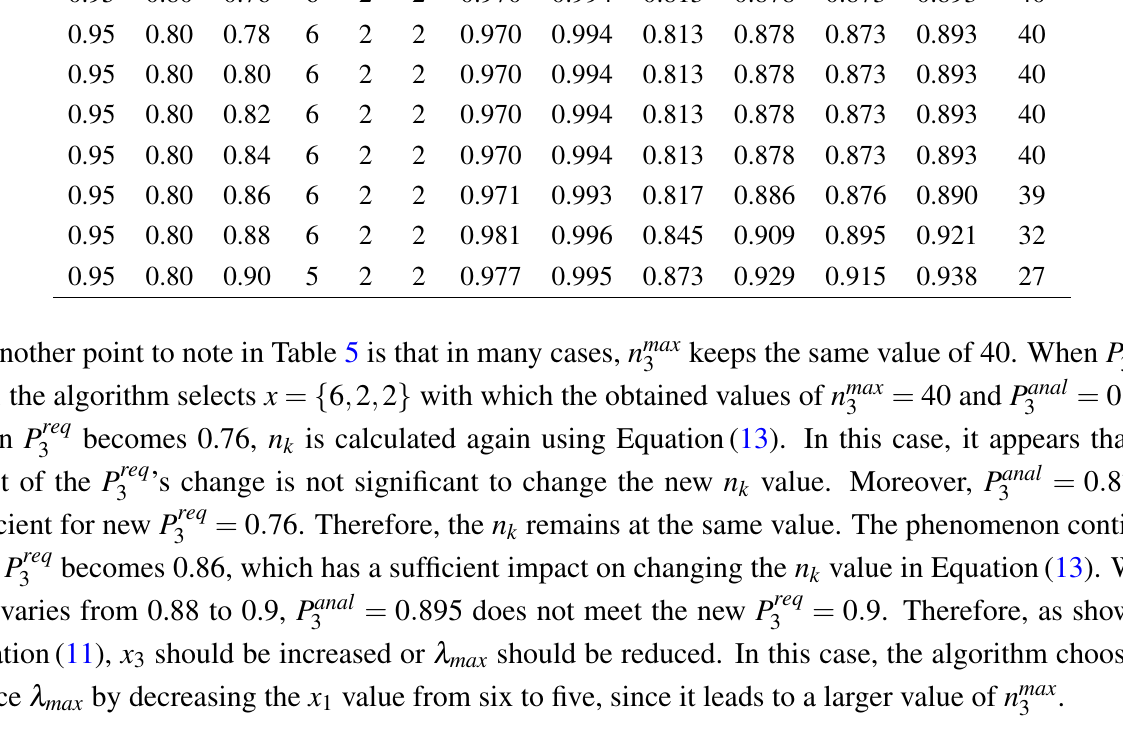
Table 5. The effects of the PDR requirement for class Q